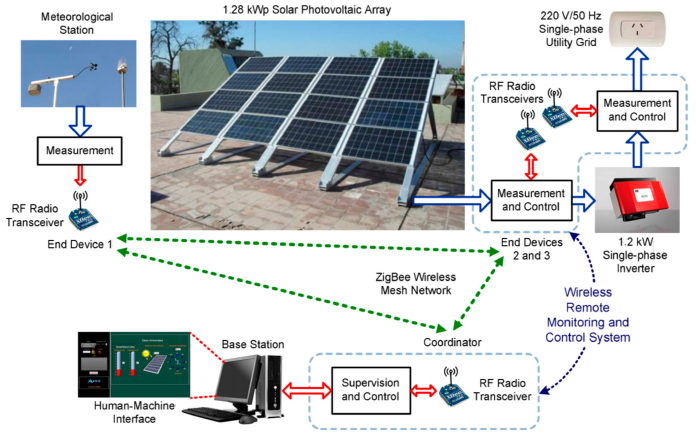
Figure 1. Photovoltaic cell, module, and array for various applications.